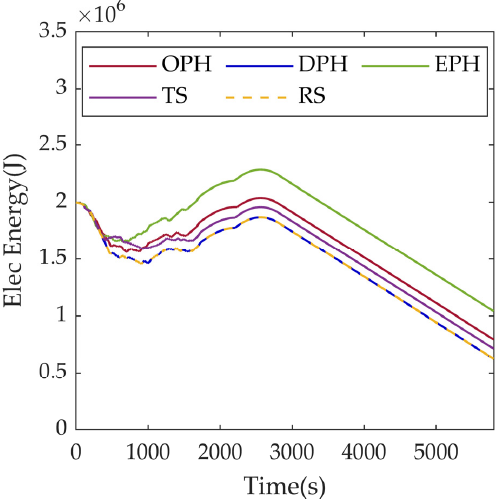
Figure 12. Satellite electrical energy diagram of a single condition in the second group.